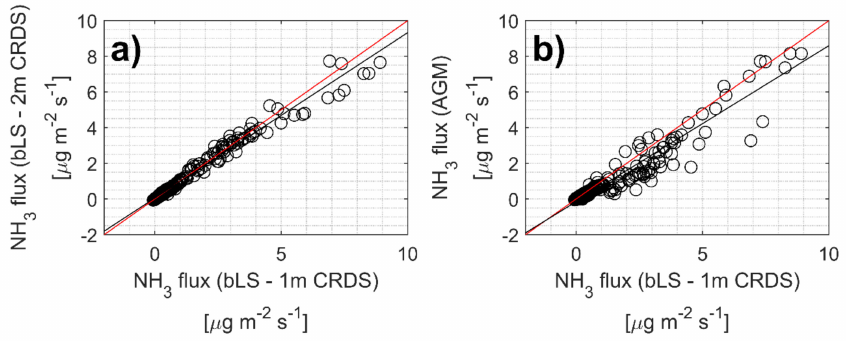
Figure 6. Correlation between the NH 3 fluxes estimated by ( a ) CRDS-bLS 1 m and CRDS-bLS 2 m and ( b ) CRDS-bLS 1 m and AGM in the May campaign. The black lines are Deming regression lines, and the red lines are 1:1 lines. The regression coefficients are shown in Table 4.